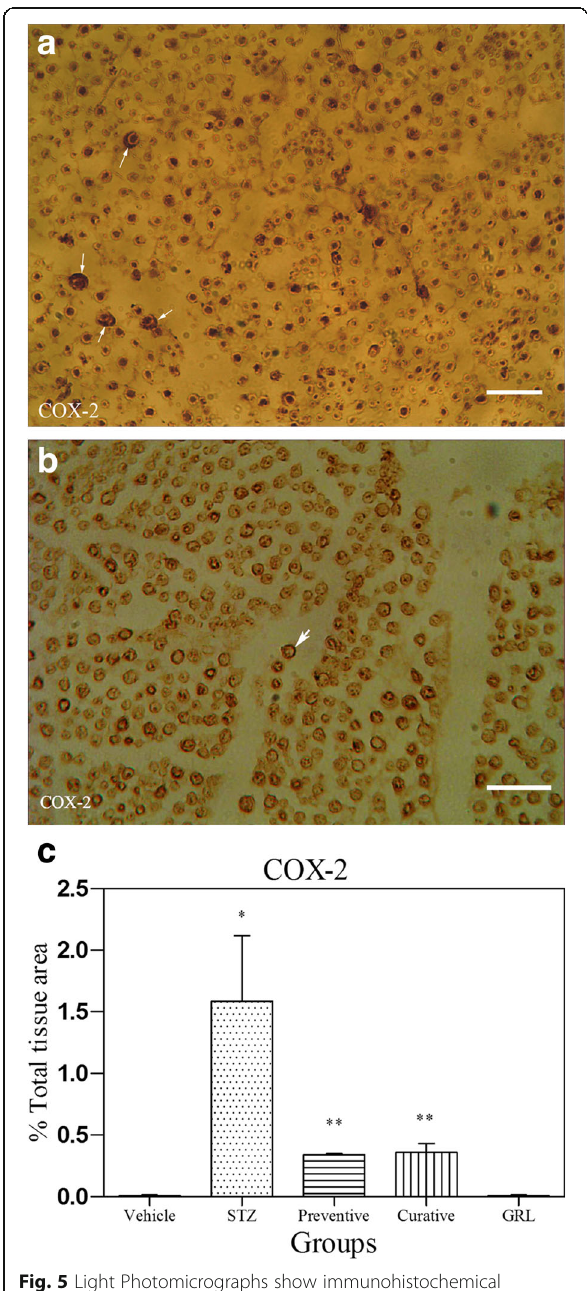
Fig. 4 Light Photomicrographs show immunohistochemical expression of caspase-3 in STZ ( a ) and STZ plus GRL ( b ) groups (original magnification: ×400, bar: 250 μ m). The positive staining of caspase-3 is presented by a brown color of cytoplasm (arrows). Densitometry analysis of immunohistochemical photomicrographs for caspase-3 was assessed. Data are expressed as a percentage of total tissue area ( c ) of 7 rats/group. * P < 0.001 versus vehicle and GRL group; ** P < 0.001 versus STZ group by one-way ANOVA followed by Tukey ′ s post-hoc tests